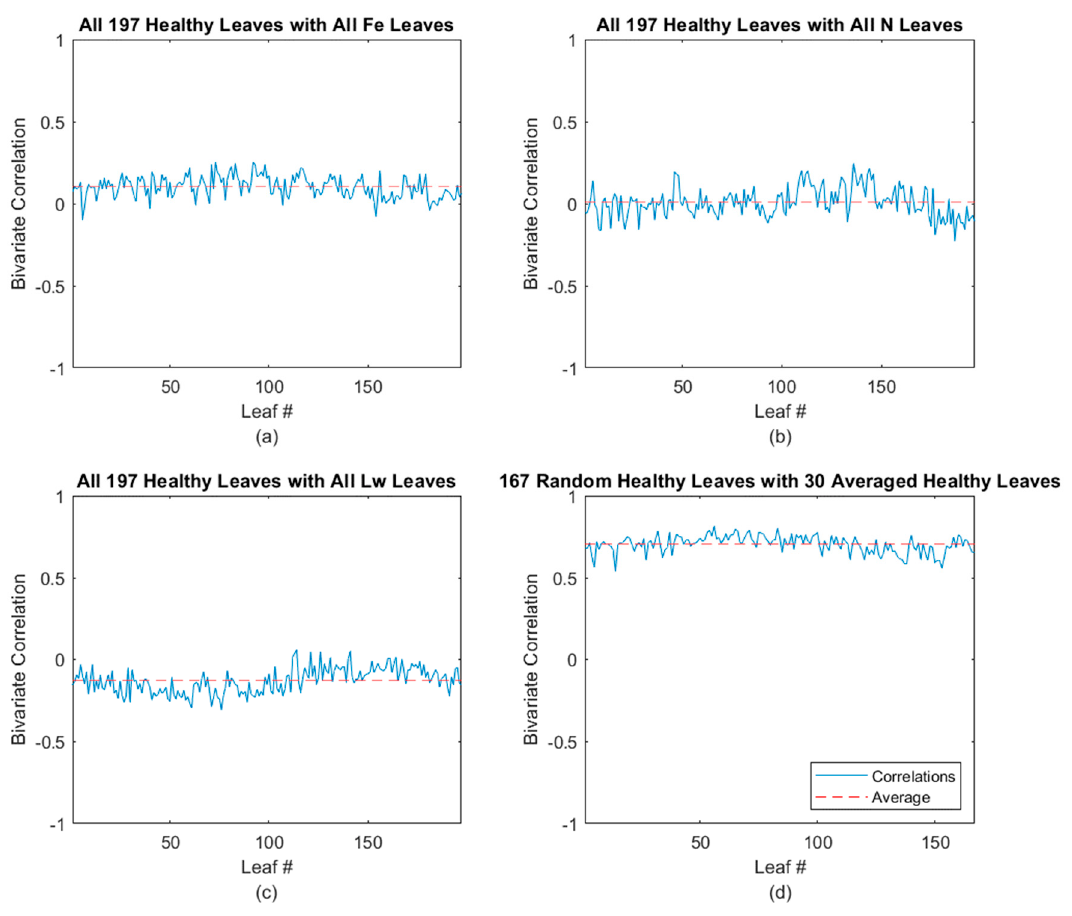
Figure8. FDA-BCalgorithmappliedforhealthyavocadoleaves: ( a )HealthycorrelatedwithFe-deficient; Figure 8. FDA ‐ BC algorithm applied for healthy avocado leaves: ( a ) Healthy correlated with Fe ‐ ( b ) Healthy correlated with N-deficient; ( c ) Healthy correlated with Lw; and ( d ) Healthy correlated deficient; ( b ) Healthy correlated with N ‐ deficient; ( c ) Healthy correlated with Lw; and ( d ) Healthy with correlated with healthy.